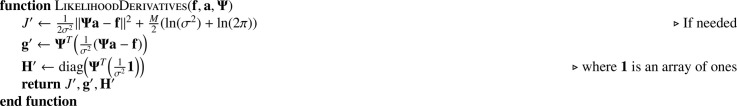
Likelihood derivatives for Gaussian noise model.